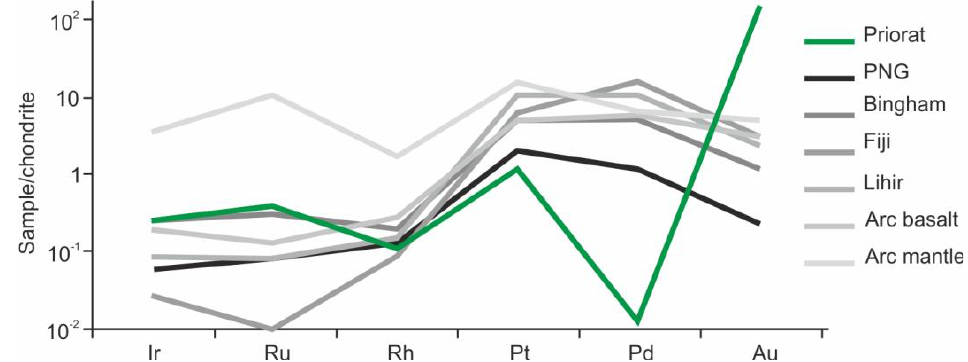
Figure 11. Distribution of platinum-group elements and gold in subduction-related shoshonites, island-arc basalt and island-arc mantle. PNG — Mid-Pleistocene shoshonite lava (average of 32 analyses) from the Mount Hagen volcano, Papua New Guinea [106]; Bingham — potassic lava as- sociated with giant (>500 million tons of ore), high-grade (>1% Cu and >1 g/t Au) Bingham Canyon Cu – Mo – Au deposit, Utah, USA [107]; Fiji — Late Miocene — Early Pliocene shoshonite associated with high-grade (7 g/t Au) Emperor (Vatukoula) epithermal gold deposit (3.6 Moz of contained Au) in Fiji [107]; Lihir — Late Pleistocene (0.36 Ma) shoshonite associated with giant (56 Moz at 2.3 g/t Au) Ladolam low-sulfidation epithermal gold deposit on the Lihir Island in the Ta- bar-Lihir-Tanga-Feni island arc near Papua New Guinea [107]; Arc basalt — modern primitive (~9 wt.% MgO) calc-alkaline basalt (average of 12 analyses) from the active Tolbachik volcano, Kam- chatka arc [108]; Arc mantle — average (16 analyses) composition of depleted mantle wedge-derived peridotite xenoliths from the Avachinsky volcano, Kamchatka volcanic arc [109,110]. Chondrite normalization values are from [44]. 6. Conclusions The Catalan Coastal Ranges (CCR) in NE Spain is a horst and graben mountain system, which includes deformed (folded and faulted) Paleozoic basement composed in the Priorat DOQ region of Catalonia of black shale, volcaniclastic sediments (sandstone, mudstone, siltstone), potassic lava flows and sills and lithocrystalloclastic tuffs. Both volcanic and volcano-sedimentary rocks are classified as high-K (black shale, volcani- clastic sediments and pyroclastics) and shoshonitic (lava flows and sills) associations, on the basis of K 2 O – Na 2 O – SiO 2 relationships. Major and trace element variations in detrital sediments indicate their general immaturity, derivation from andesitic to rhyolitic sources and accumulation within an Andean-type active continental margin environ- ment. Geochemical systematics in volcanic shoshonites show their general trace ele- ment-enriched compositional character and suggest derivation from a metasomatized (by recycled sediment melt, adakitic slab melt or slab fluid) variably depleted mantle source in a mature (well-developed), rifted subduction zone setting. We propose that volcano-sedimentary rocks comprising the structural basement of the CCR were formed within the rifted Andean-type margin or Western Pacific-type arc — backarc tectonic en-